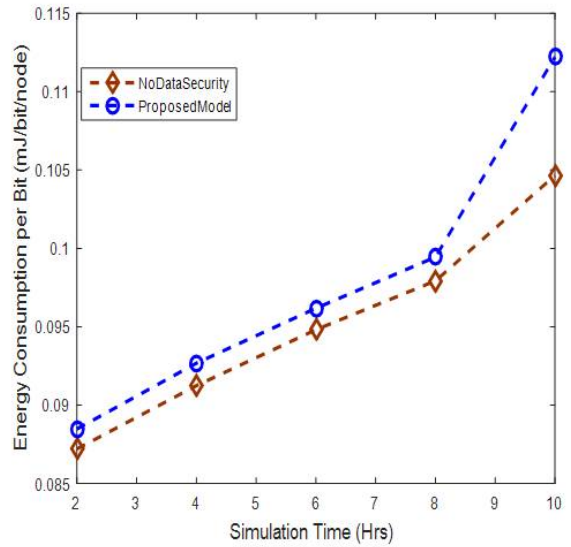
Figure 10. Energy consumption per bit versus simulation time.